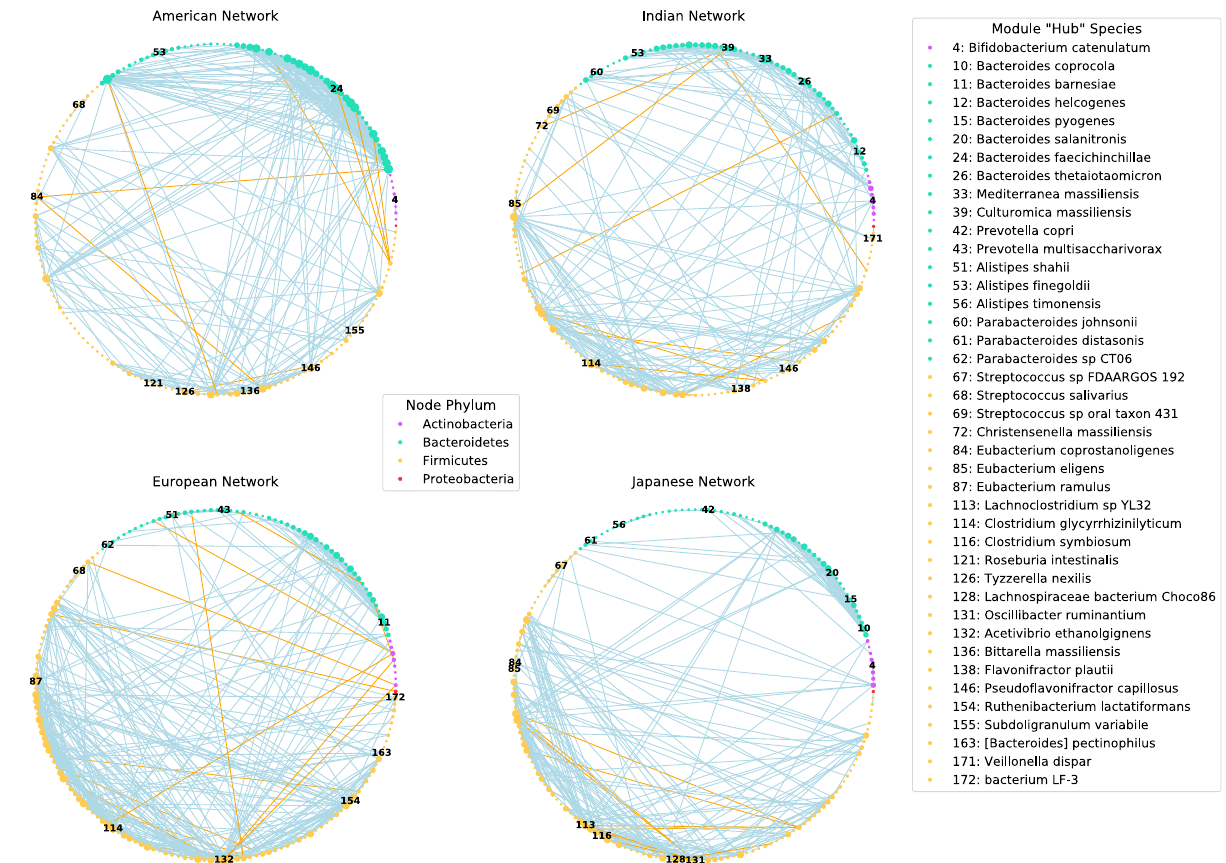
Figure 2. Species-level bacterial association networks. Network modeling of associations between (173/202) signature species within each network. A total of 29 species were not shown as they had zero edges in all networks. Node color designates the phylum each species belongs to, node size is reflective of node degree, and edge color represents if the association is positive (blue) or negative (orange). Nodes are ordered counterclockwise around the circle by the alphabetical order of the concatenated string of all taxonomic levels. Nodes that are numbered correspond to species with the highest degree centrality within modules, designated as “hubs”. Brackets around [ Bacteroides ] pectinophilus indicate that it is misclassified (i.e., placed incorrectly in a higher taxonomic rank and awaiting to be formally renamed). We utilized Blast to designate [ Bacteroides ] pectinophilus as belonging to the phylum Firmicutes 91 . For a full list of species shown and not shown within network models see Supplemental.